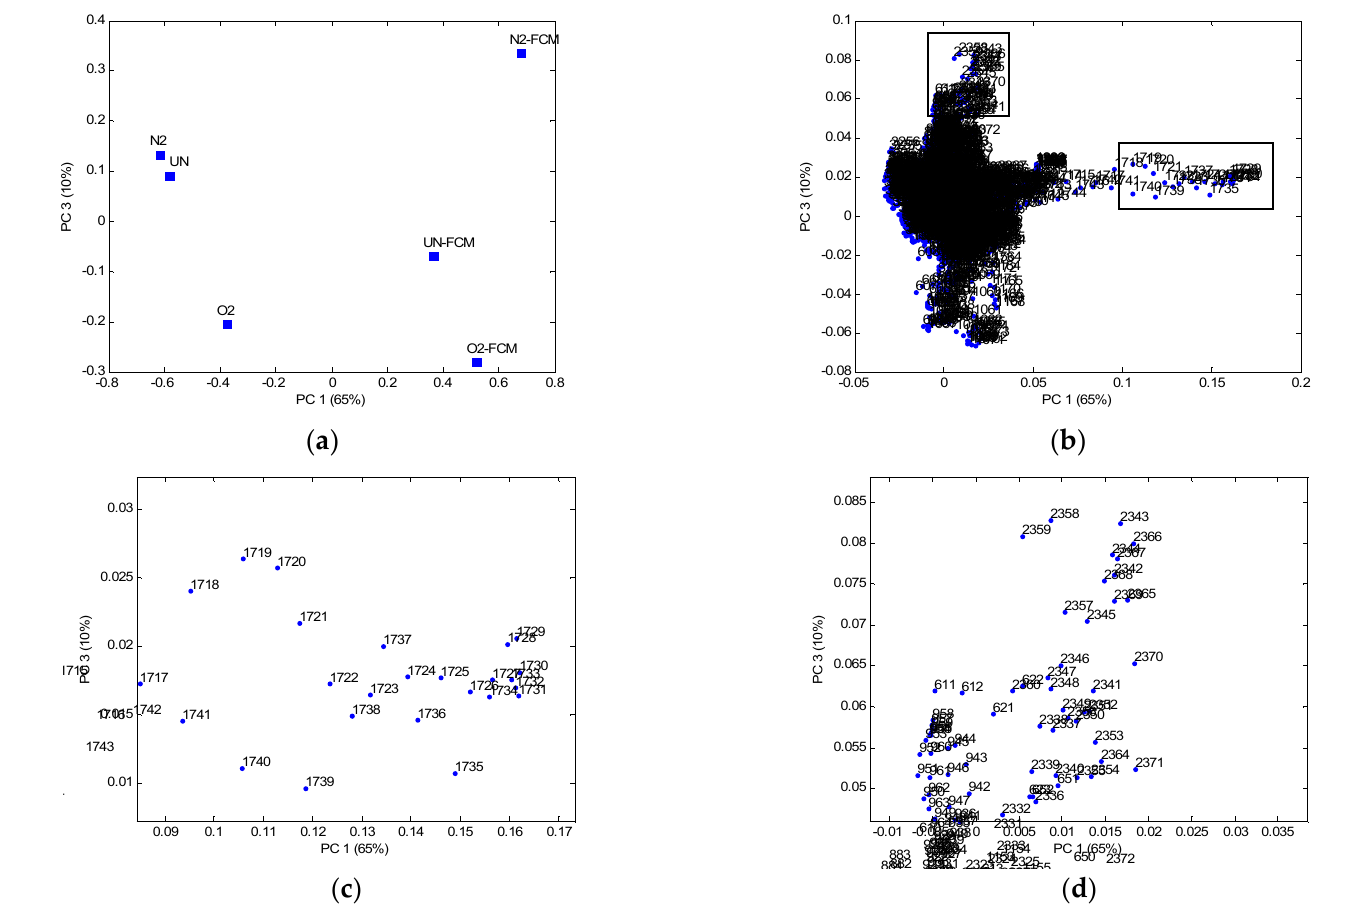
Figure 9. PC1-PC3 score plot ( a ) and PC1-PC3 loading plots ( b – d ). A closer look at the original spectral data shows that the most striking difference be- tween the uncoated and FCM-coated samples is the presence or absence of an absorption peak at wavenumber 1730 cm −1 (see Figure 7b). The PC1-PC2 score and loading plots— Figure 8a–c—confirm this fact. PC1, which accounts for most of the FTIR information (65%), distributes the samples horizontally from left to right according to their absorption at that wavelength (the rightmost data point in Figure 8c). While the uncoated samples on the left (UN, O 2 , N 2 ,) show no absorption, the three samples coated with FCM (UN-FCM, O 2 -FCM, N 2 -FCM) show strong peaks at this wavenumber. Moreover, the intensity peak of sample N 2 -FCM is the highest, followed by samples O 2 -FCM and UN-FCM, which means that more FCM was adsorbed on the cotton fabric after treatment with N 2 plasma. The absorption intensity of each sample corresponds to its horizontal constellation in Fig- ure 8a. The samples also differ, albeit less clearly, in terms of their absorption intensity in the wavenumber region between 2915–2930 cm −1 (see Figure 7c). Accordingly, the verti- cal—i.e., along PC2—position of the samples in the PC1-PC2 score plot (Figure 8a) corre- sponds exactly to their absorption values at 2924 cm −1 : the untreated sample (UN) has the highest absorption, followed by UN-FCM, O 2 -FCM, etc., while O 2 is characterized by the lowest absorption intensity. Finally, PC3, which accounts for only 10% of all spectral in- formation, arranges the samples according to their absorption intensity in the 2330–2380 cm −1 region. As shown by the similarity of the positions of the samples and wavenumbers in Figure 9a,d, the absorption is strongest for the N 2 -FCM sample (upper regions of both plots) and decreases towards O 2 -FCM, which has the lowest absorption. These results are consistent with previous ones (i.e., SEM, fragrance intensity, and air permeability). Exam- ining the two score plots, one can assign a physical mean to two of the first three PCs. As mentioned above, PC1—the horizontal axis in Figure 8a—is related to the presence (N 2 - FCM, O 2 -FCM, UN -FCM) or absence of microcapsules (N 2 , O 2 , UN) on the samples. On the other hand, PC3—the vertical axis in Figure 9a—separates the samples in terms of presence and type of plasma treatment: in the upper part of the diagram, we find both N 2 plasma-treated samples (N 2 -FCM and N 2 ), untreated samples (UN and UN-FCM) are lo- cated in the middle, while both O 2 plasma-treated samples (O 2 , O 2 -FCM) are found in the lower part of the diagram. 4. Conclusions In this study, cotton fabric was treated with a low-pressure capacitively coupled plasma system using oxygen or nitrogen gases and coated with fragrance microcapsules (FCM). The effect of plasma treatment was evaluated with SEM, the mechanical properties and wicking ability of the fabric, the adsorption of FCM on cotton with SEM and FTIR, and the adsorption and adhesion of FCM on cotton with the SEM, air permeability, and fragrance intensity after repetitive domestic washing. The results show that the plasma